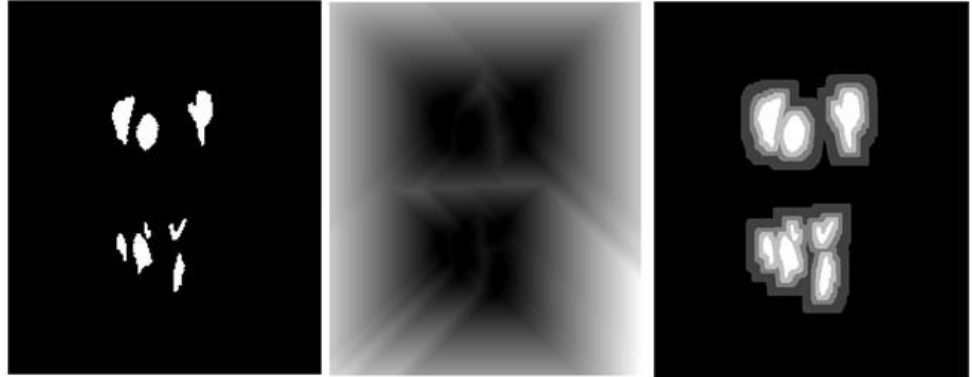
Figure A1. ( Left ) Tumor mask, ( Middle ) Distance transform, and ( Right ) Distance Mask. The multi-level distance masks are five-level masks with non-tumor regions, and the tumor distance mask in the specific threshold as shown in Figure A2: